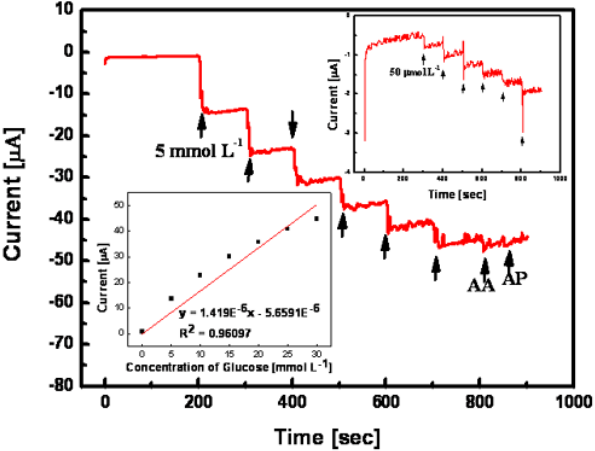
Figure 9. Amperometric current response of optimized non-enzymatic glucose micro- sensor to the consecutive addition of 5 mmolL -1 glucose and 0.1 mmolL -1 interfering species (AA and AP) in 0.1 molL -1 PBS (pH